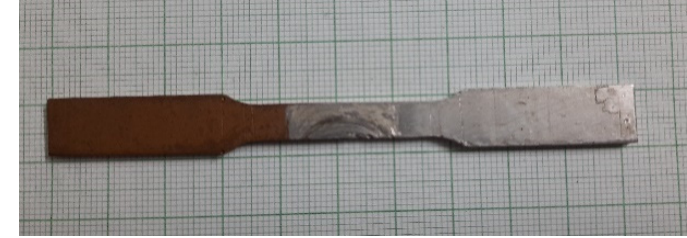
Figure 6. Tensile test specimen (sample no.